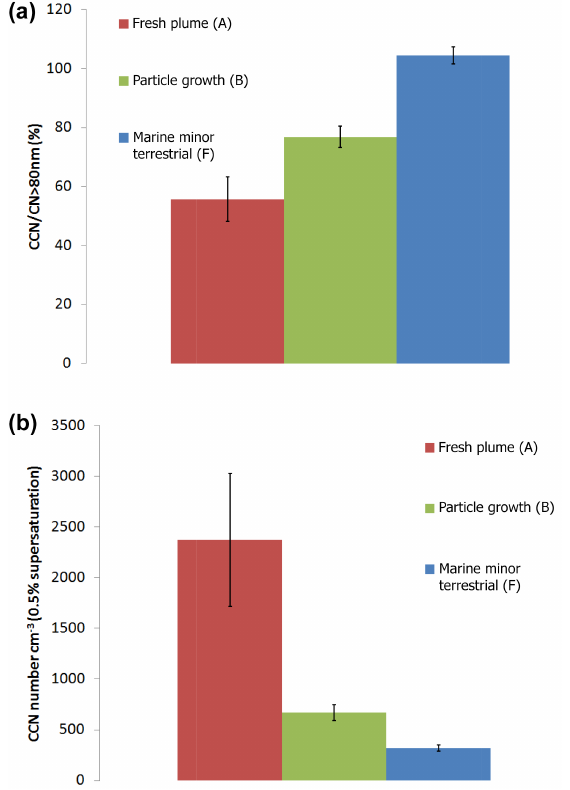
Figure 5. (a) Average ratios of CCN / CN > 80 (hourly) in BB1 during fresh plume (Fig. 3, Period A), particle growth event (Fig. 3, Period B), and in marine air with minor terrestrial influence (Fig. 3, Period F). (b) Average absolute number concentrations of CCN (hourly) during the same periods. Error bars are one standard er- ror of the